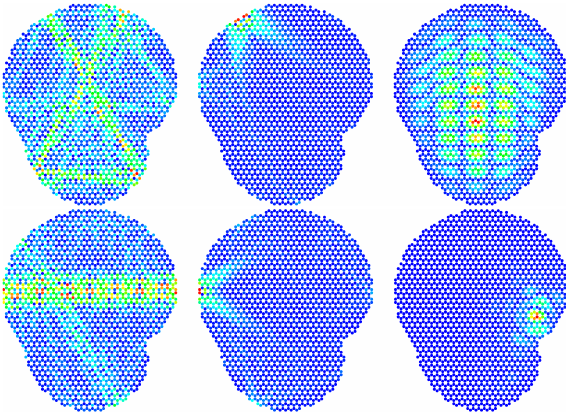
Figure 11. The same as in Figure 10 for the Africa-shaped hexagonal lattice with 1979 sites.